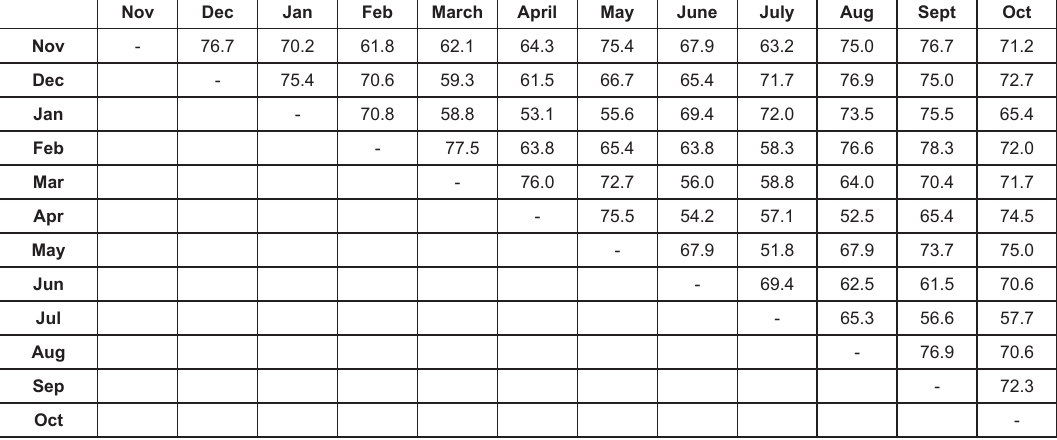
Table 4. Percentage similarities between Zooplankton communities (2002-03)